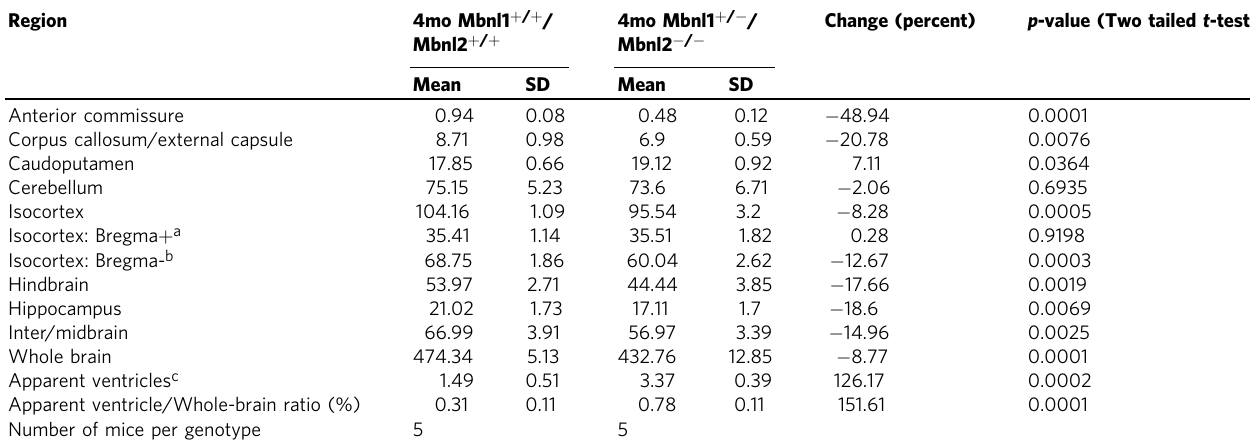
Table 1 Summary of brain region volumes (in mm 3 ) from 4-month-old Mbnl1 + / + /Mbnl2 + / + and Mbnl1 + / − /Mbnl2 − / − mice.